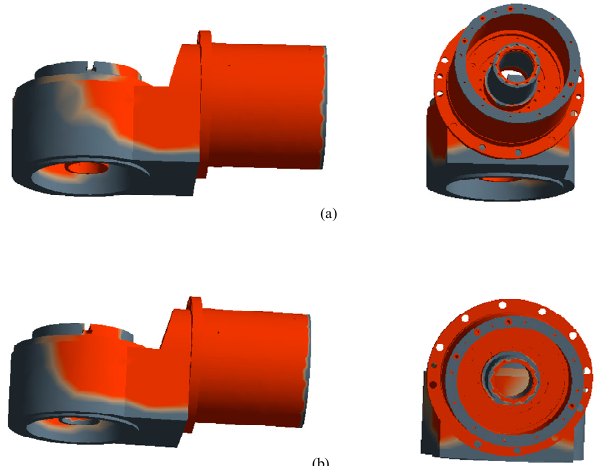
Figure 18. Topology optimization results of direct-drive turntable in turning condition: ( a ) 50% mass retention rate; ( b ) 60% mass retention rate.